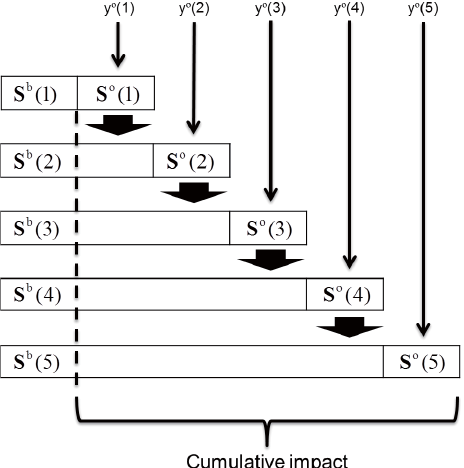
Figure 2. Schematic diagram of calculating cumulative impact in CarbonTracker. S b ( · ) indicates the analysis sensitivity to back- ground at each analysis cycle within 5 weeks of lag, where · de- notes each week from 1 to 5. S o ( · ) indicates the analysis sensitivity to observation at each analysis cycle.